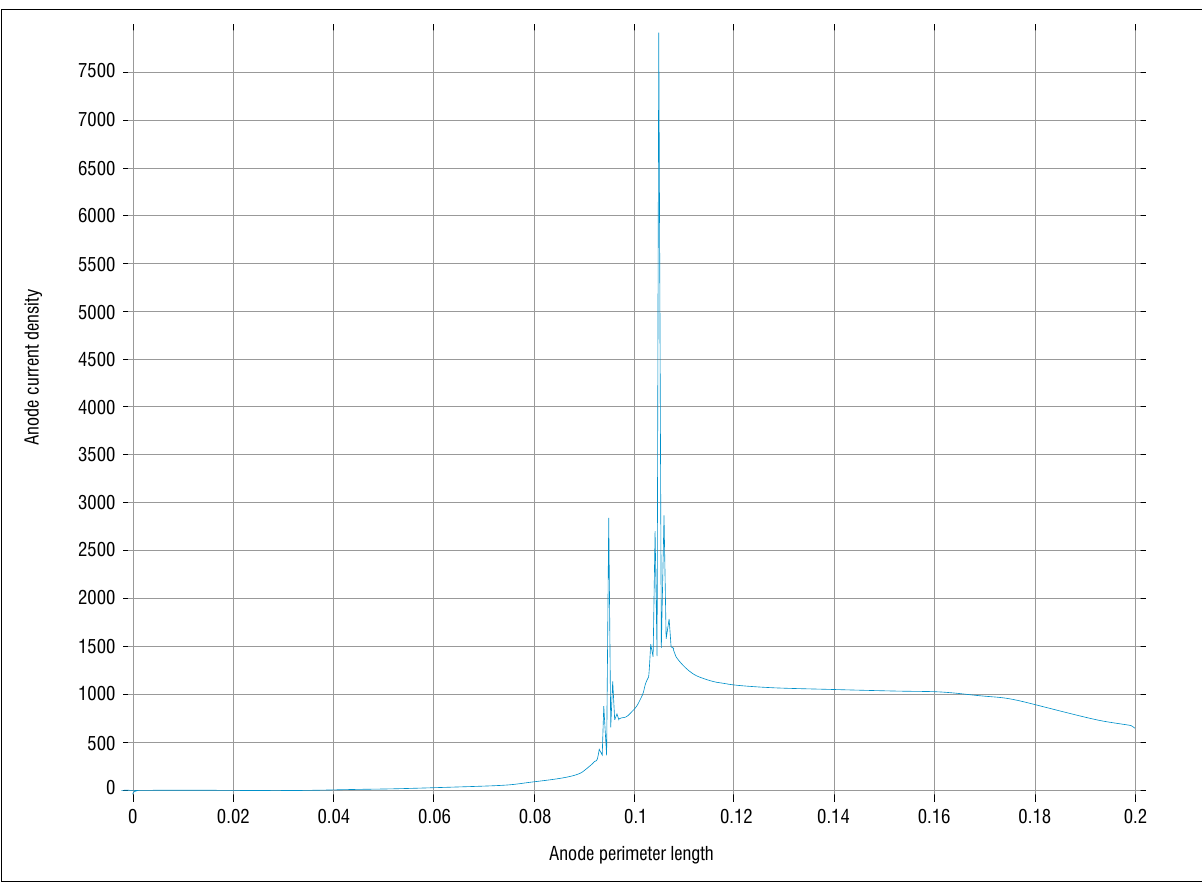
Figure 7: Current density variation (in A/m 2 ) along the perimeter length (in m) of the anode from the outside at electrolyte level to the inside of the anode at electrolyte level.